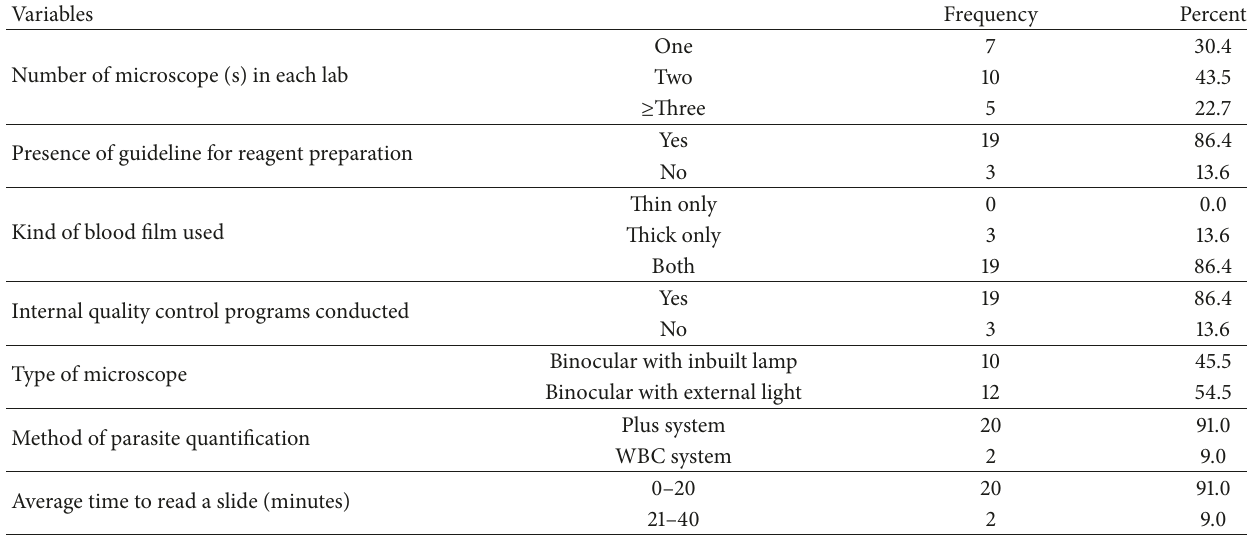
Table 2: General laboratory setups of selected health institutions in Tigray, North Ethiopia, 2016. Variables